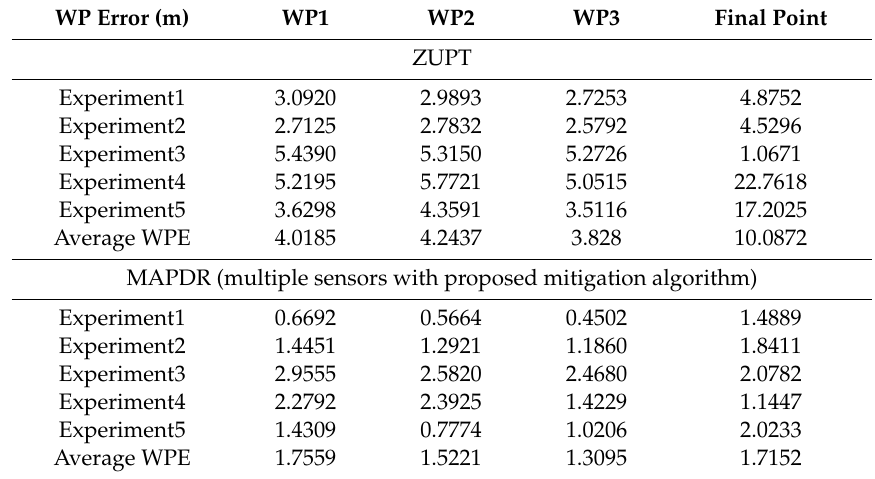
Table 6. Comparison of MAPDR and conventional PDR case of the partial map in experiment site 1.